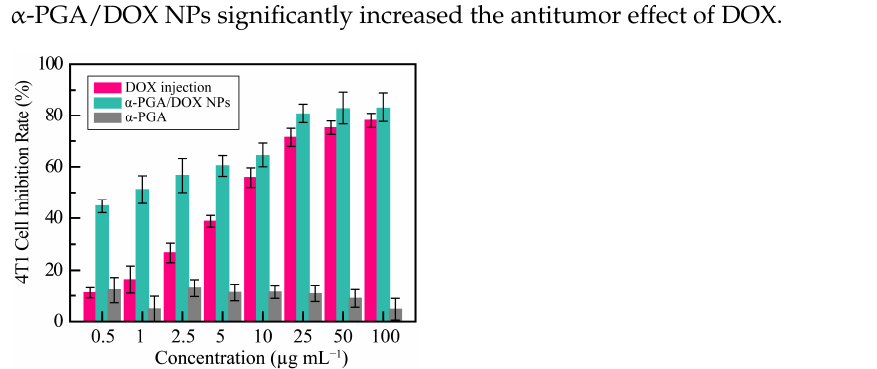
Figure 4. Cumulative release rate of α-PGA/DOX NPs in PBS solution ( n = 3).